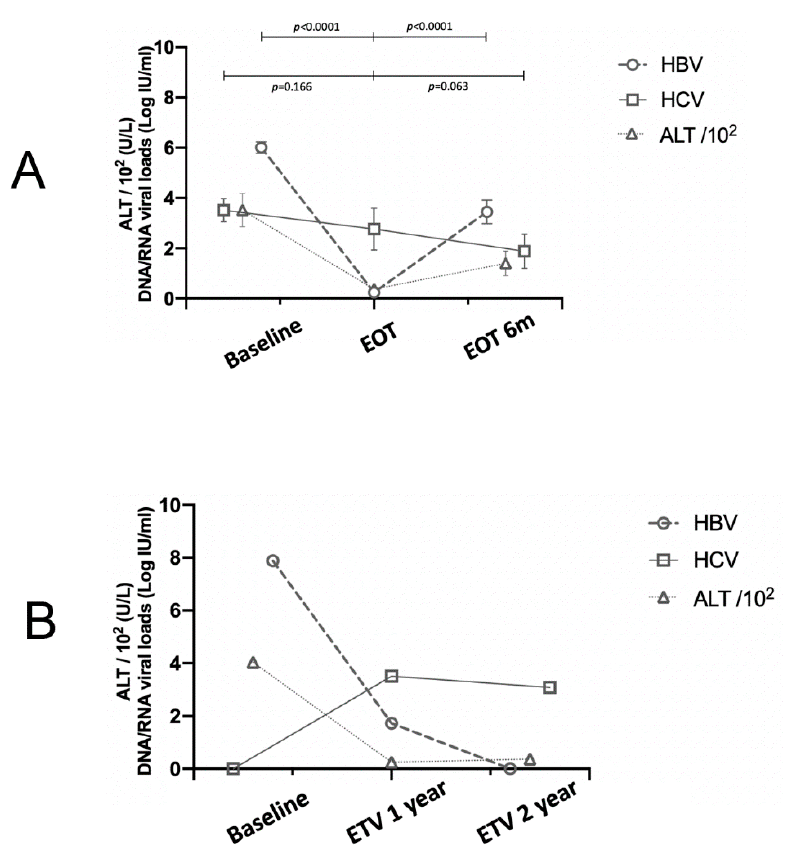
Figure 2. ( A ) HBV DNA, HCV RNA, and ALT level evolutions among the 68 CHB patients. EOT: end of therapy, EOT 6 m: 6 months after EOT. ( B ) HBV DNA, HCV RNA and ALT level evolutions of HCV reaction in a patient with previously resolved HCV infection. ETV: entecavir. Table 2. Viral load evolution of HCV reactions of two CHC patients.